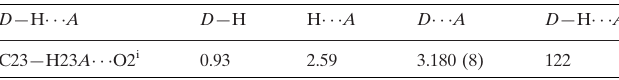
Hydrogen-bond geometry (A˚ , (cid:3)